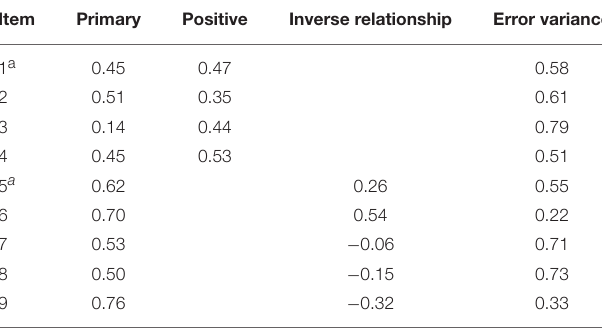
TABLE 3 | CFA bifactor model